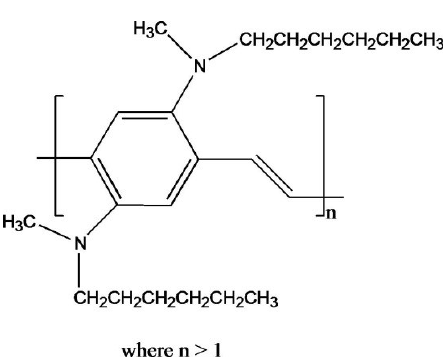
Figure 1. Structure of